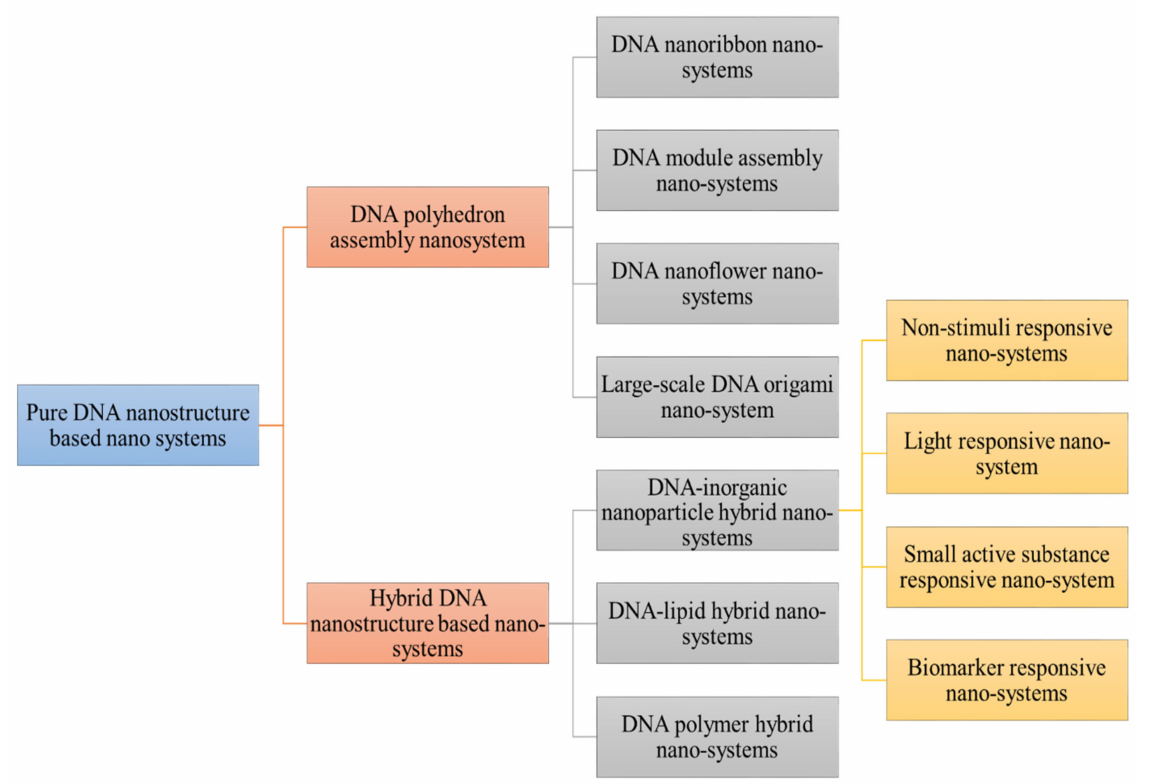
Figure 1. Demonstrated different classification of DNA nanostructure. Pure DNA nanostructure is divided into DNA polyhedron assembly nanosystem (DNA nanoribbon, DNA module assembly nanosystem, DNA nanoflower system) and hybrid DNA nanosystem (DNA-inorganic nanoparticle hybrid nanosystems (non-stimuli responsive, small active responsive, biomarker responsive) DNA lipid hybrid and DNA polymer hybrid